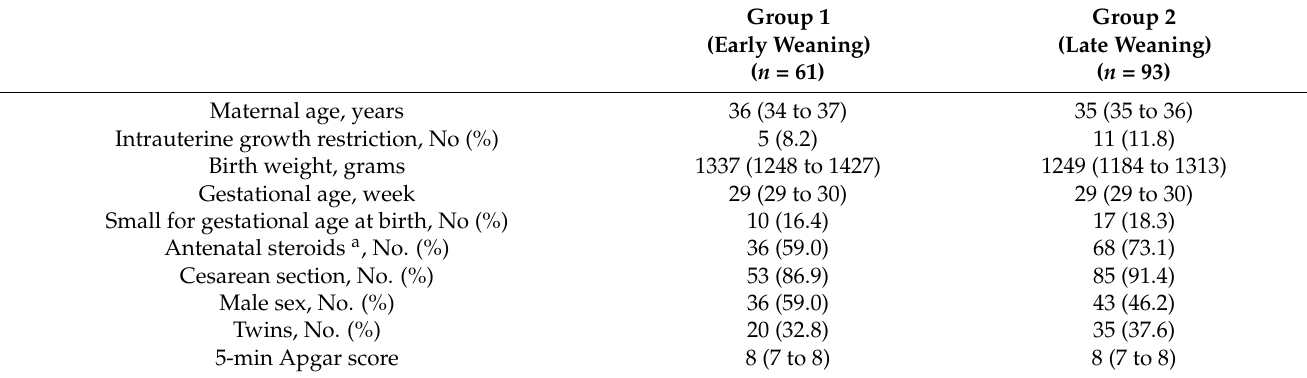
Table 1. Baseline clinical characteristics of the study